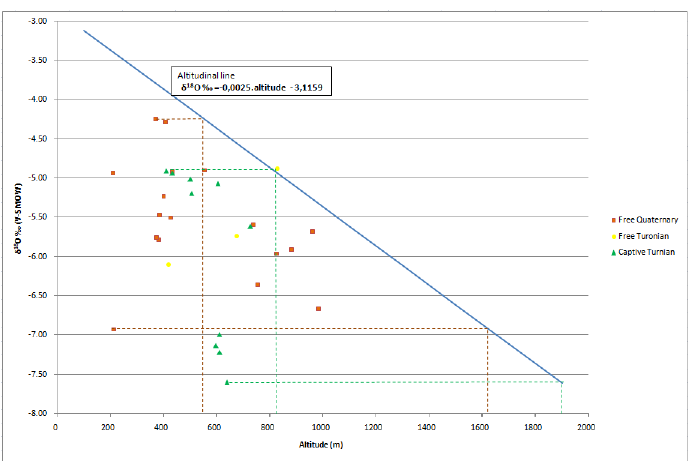
Figure 16. Correlation between Nitrates and: ( a ) 18 O, ( b ) EC, ( c ) Cl − .